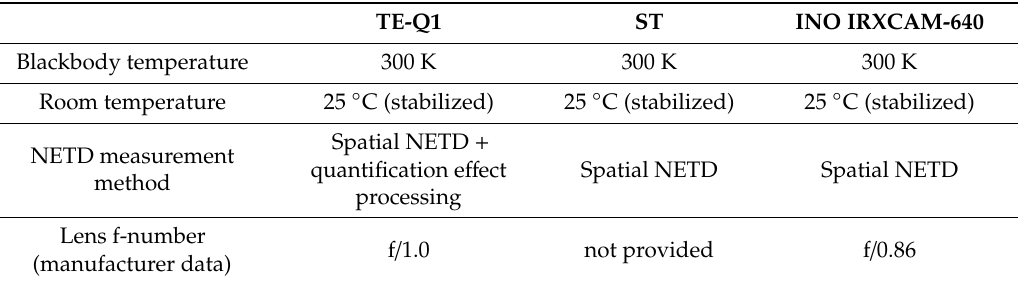
Table 3. NETD test